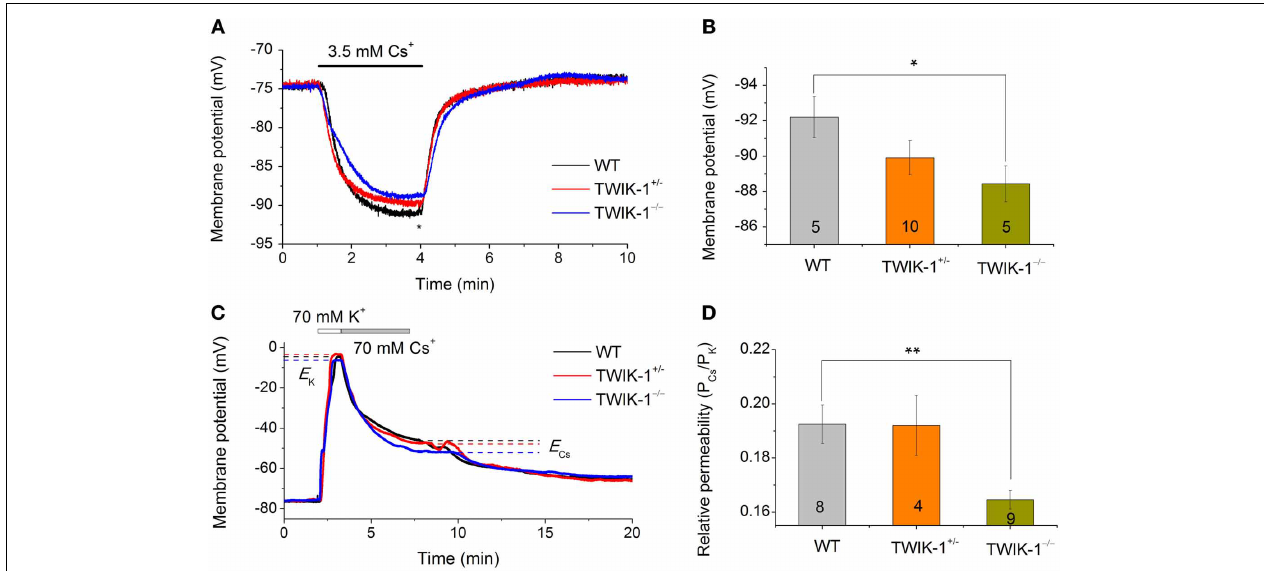
WT and TWIK-1 − / − mice was statistically significant. (C) Representative whole-cell membrane potential recording traces, with bath solutions switched from normal aCSF containing 3.5mM K + to solutions containing, in sequence, 70mM K + and 70mM Cs + . E Cs and E K are the equilibrium potential of Cs + and K + at 70mM, respectively. (D) The relative Cs + to K + permeability ( P Cs / P K ) values for three genotypes; the P Cs / P K of TWIK-1 − / − mice was significantly lower than that of the TWIK-1. Data are shown as mean ± SEM. Numbers of experiments are given within the bars. ∗ p < 0 . 05, ∗∗ p < 0 .